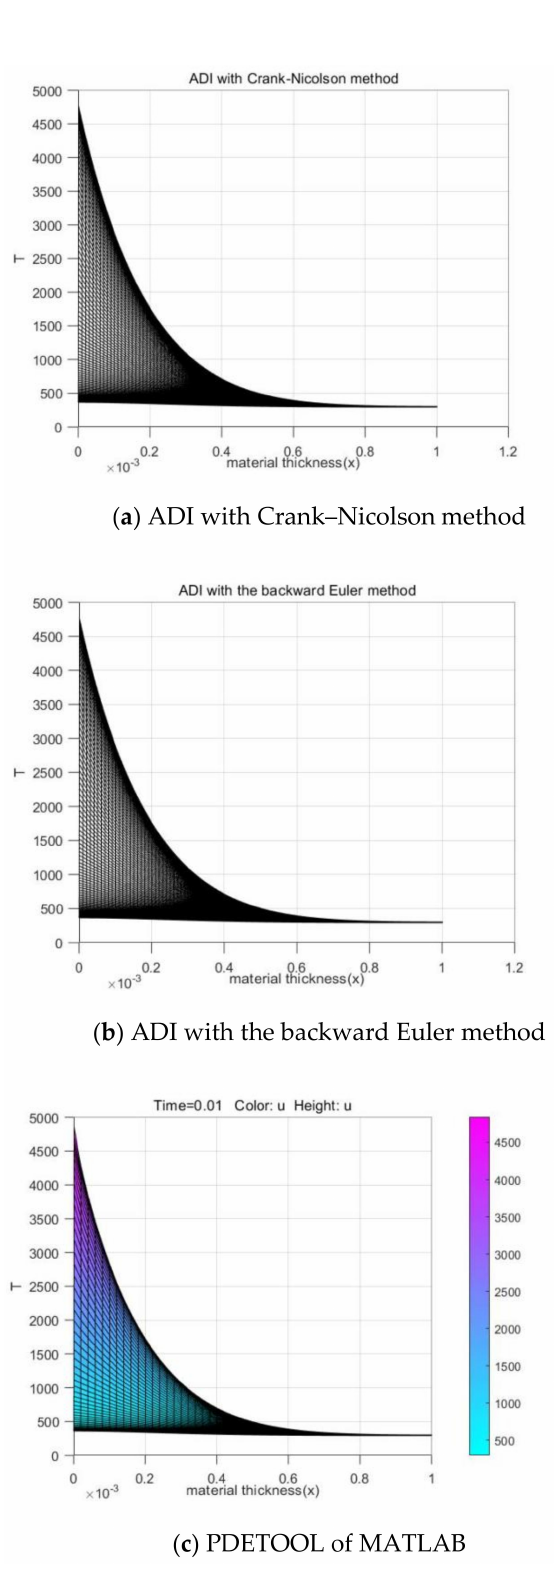
Figure 14. Cross section